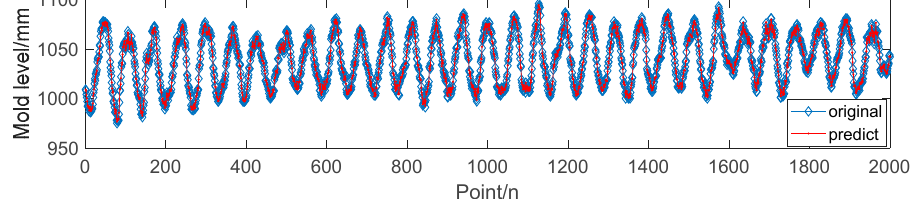
Figure 6. C and g optimization results.